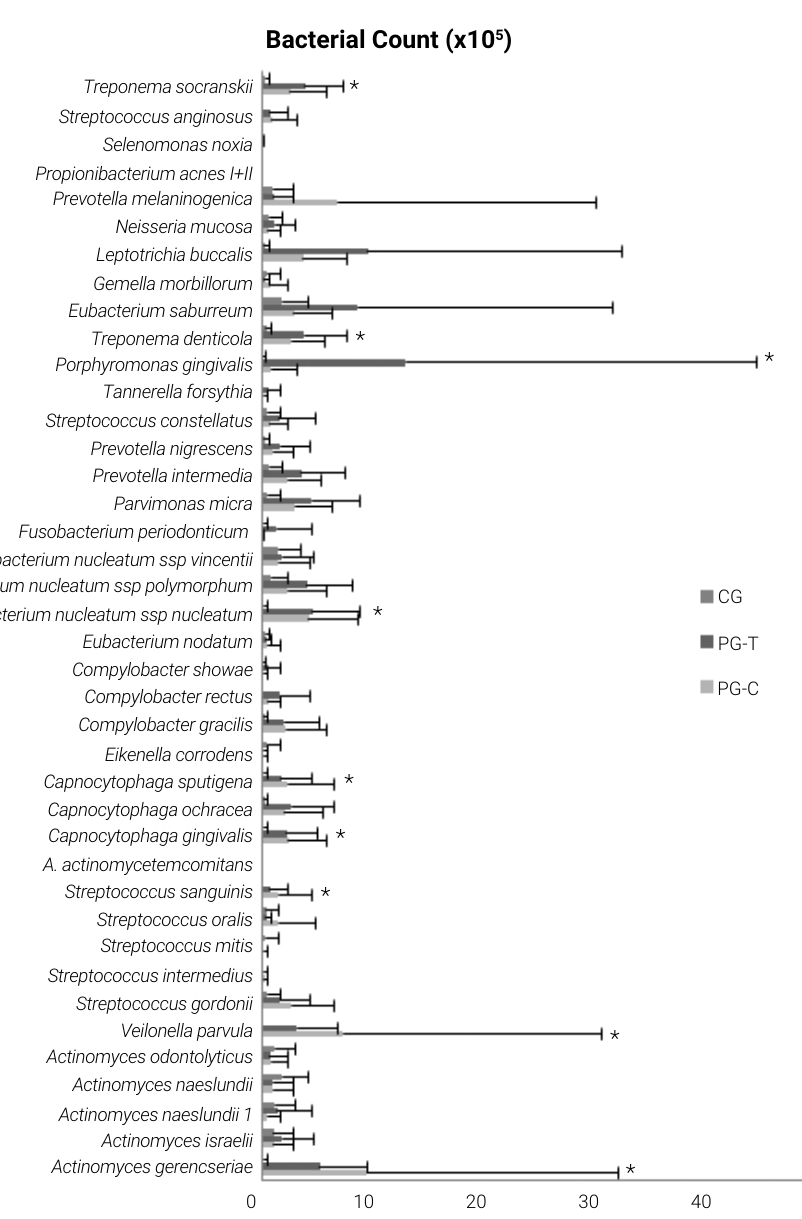
Figure 3. Mean levels (and SD) of the 40 bacterial species evaluated in the three groups (Healthy – Control, CG; Periodontitis – Test, PG-T and Periodontitis – Control, PG-C). Statistically significant differences among groups were evaluated by Kruskal-Wallis followed by Mann-Whitney Test